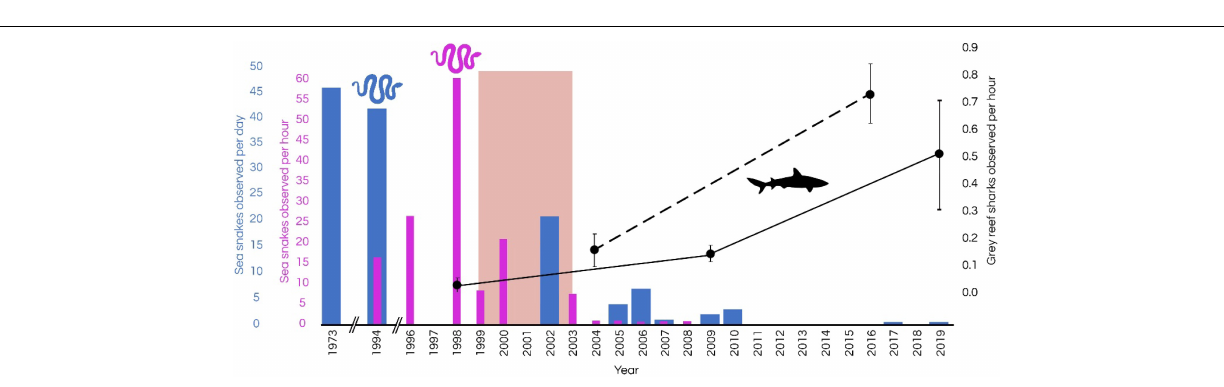
FIGURE 5 | Trends in cumulative sighting rates of sea snakes (up to 17 species; blue and purple bars) and relative sighting rate of grey reef sharks ( Carcharhinus amblyrhynchos ; black points) at Ashmore Reef Marine Park. Shark observations based on Skewes et al. (1999), Kospartov et al. (2006), Richards et al. (2009), Edgar and Stuart-Smith (2018), Speed et al. (2018), and Keesing et al. (2020). The dashed line shows trends in baited remote underwater video (BRUV) surveys and solid lines show trends in underwater visual census (UVC) surveys. The pink band shows the time of marked decline in sea snake numbers and diversity at Ashmore. Error bars show SE. Metrics of sighting rates of sea snakes and reef sharks have been standardised across studies that utilised multiple methods at multiple sites within reef-edge